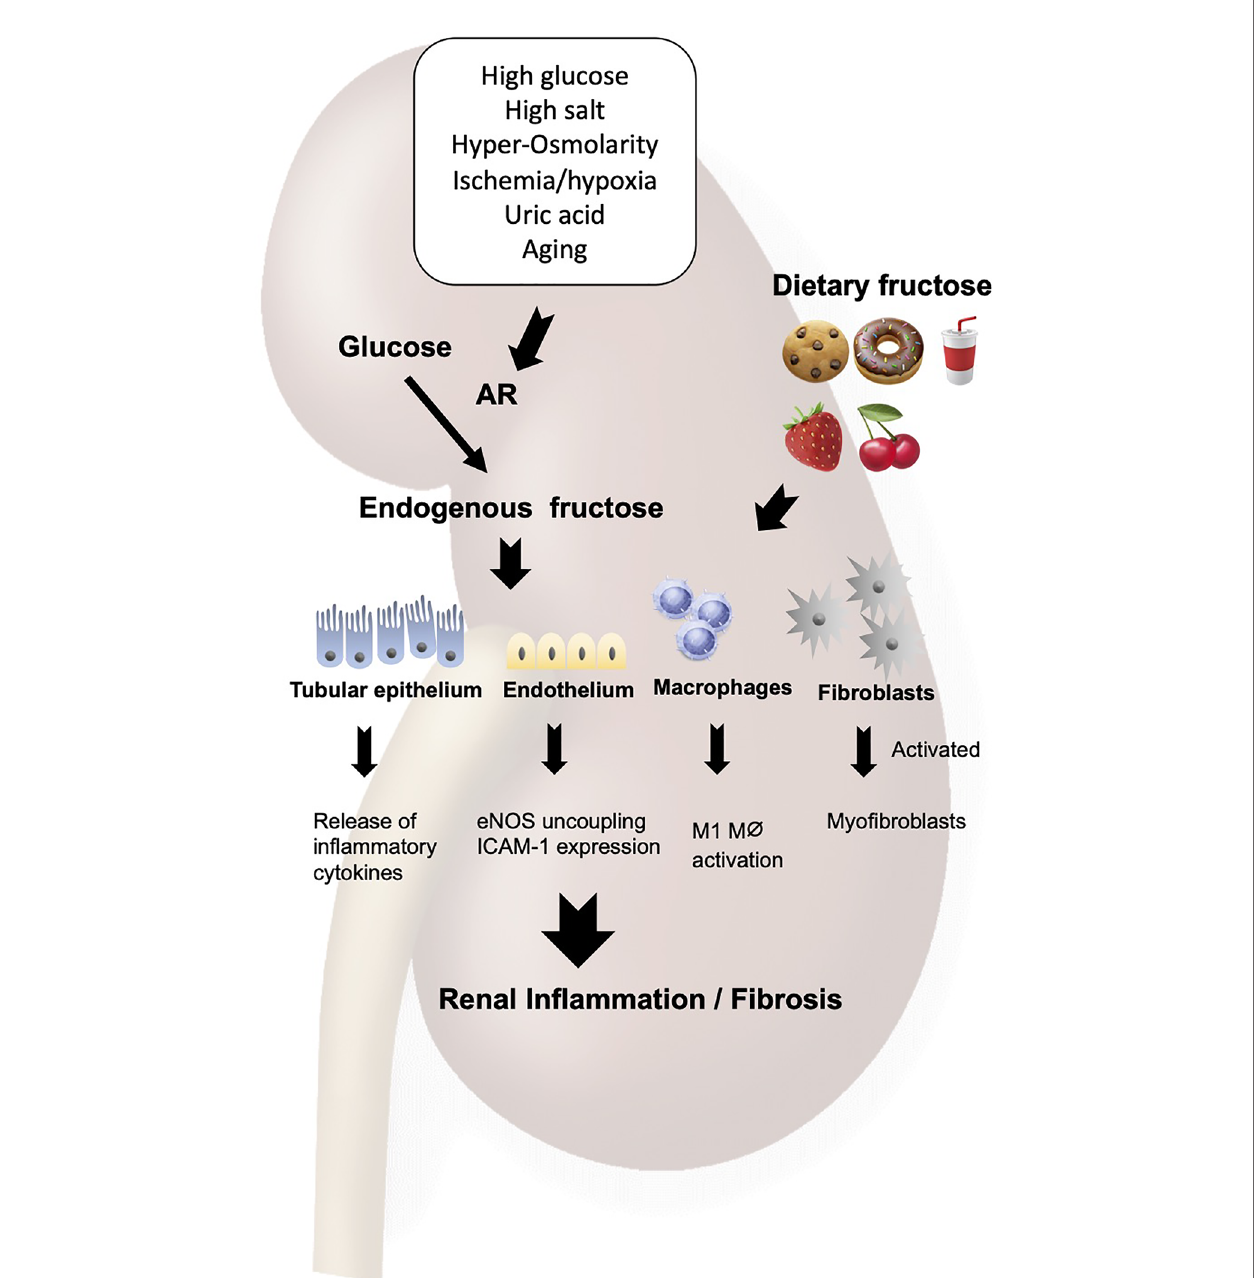
FIGURE 2 | Fructose induces renal in fl ammation. Fructose either from diet or from endogenous system under pathological condition acts on the tubular epithelial cells, endothelial cells, macrophages and fi broblasts to cause the Warburg effect, leading to in fl ammation and fi brosis in the kidney. AR, aldose reductase; ICAM-1, intercellular adhesion molecule-1; eNOS, endothelial NO